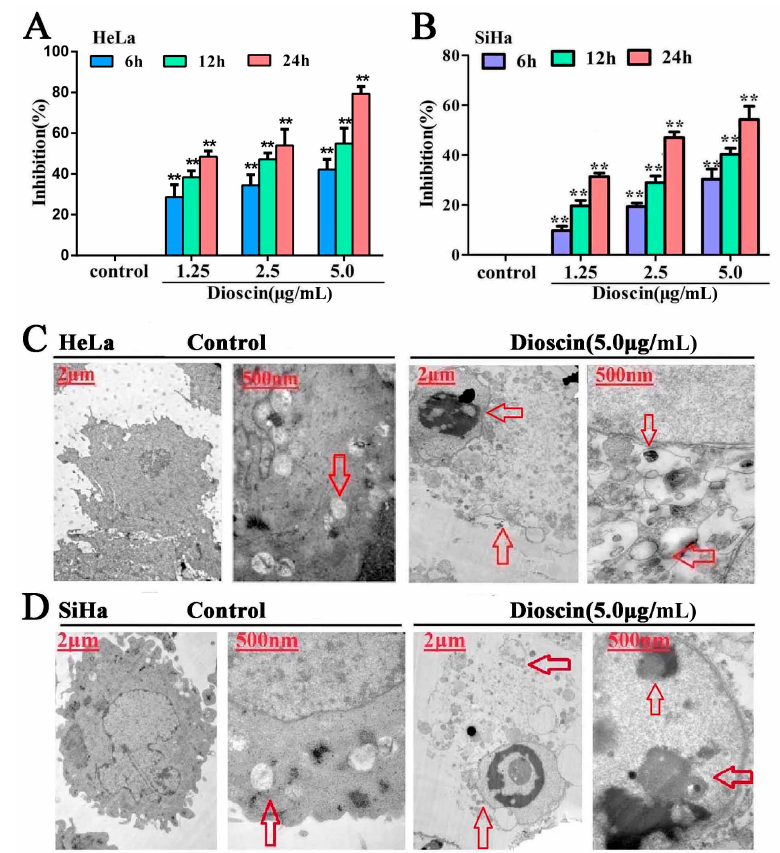
Figure 2. Dioscin inhibited cell viability and induced ultrastructure changes. ( A ) Inhibition effects of dioscin on HeLa cells; ( B ) Inhibition effects of dioscin on SiHa cells; ( C ) Effects of dioscin on the ultrastructure of HeLa cells by TEM assay; ( D ) Effects of dioscin on the ultrastructure of SiHa cells by TEM assay. Data are presented as mean ± SD ( n = 5). ** p < 0.01 compared with control group. The images of the cells gestalt structures (6000×, final magnification).